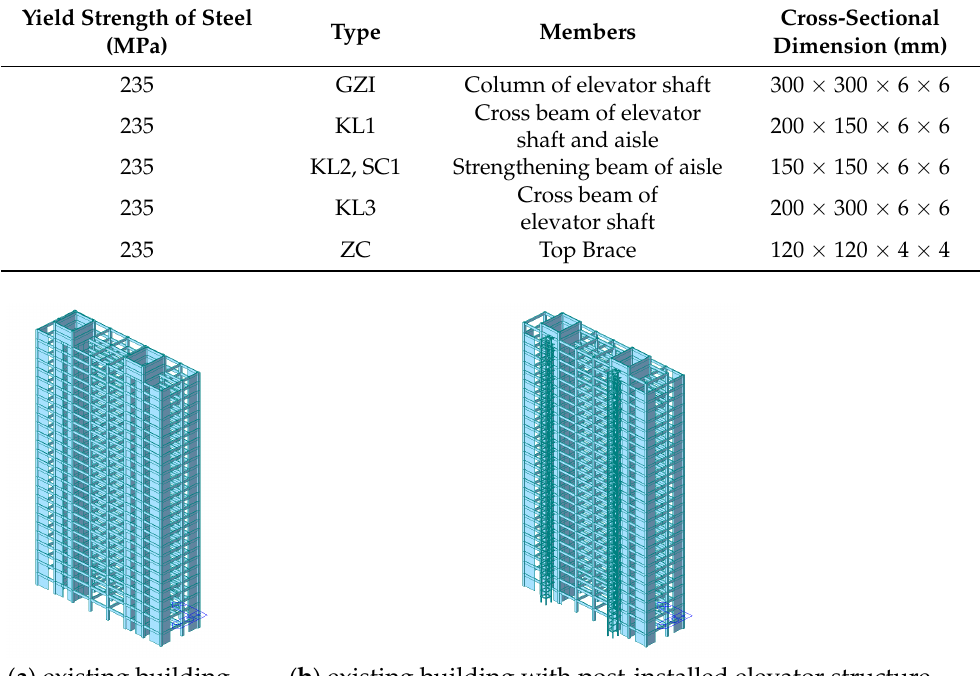
Figure 3. Finite element